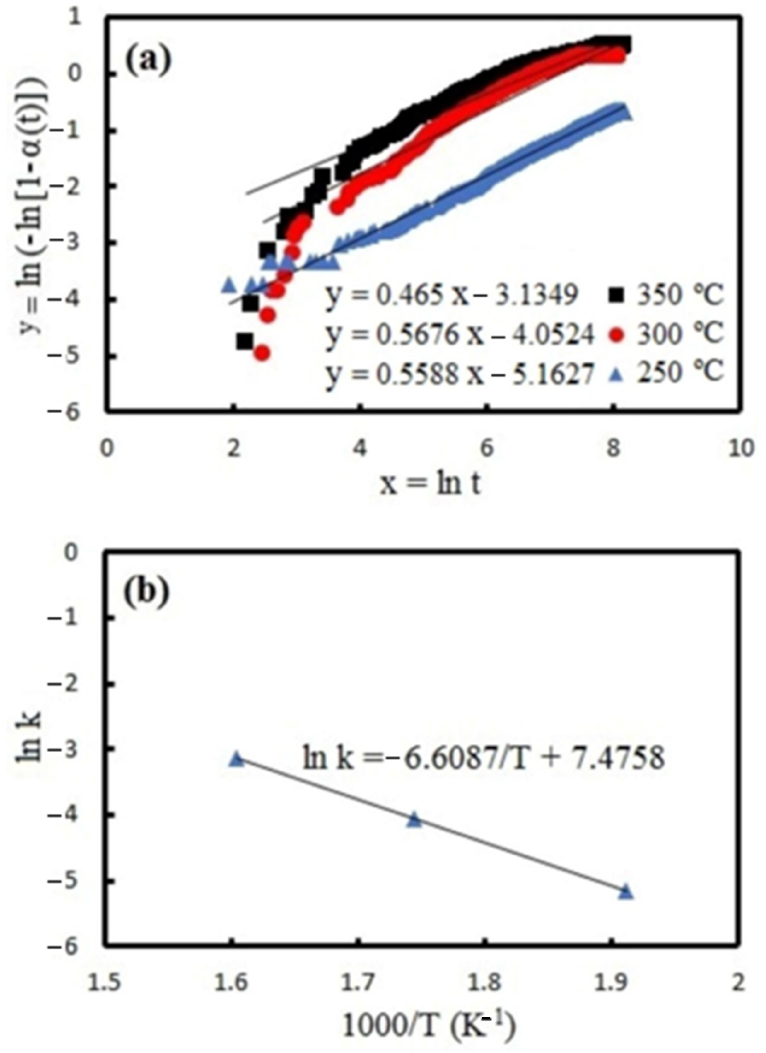
Figure 6. Determination of apparent activation energy ( Q ) for S4 sample (second pass of TPCAE at 200 ◦ C): ( a ) plotting ln [ − ln ( 1 − α )] vs. lnt at different temperatures; ( b ) Arrhenius plot of the kinetic rate constants.